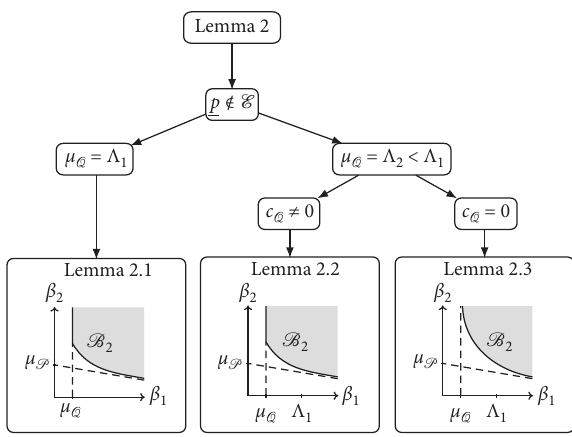
Figure 1: Illustration of Lemma